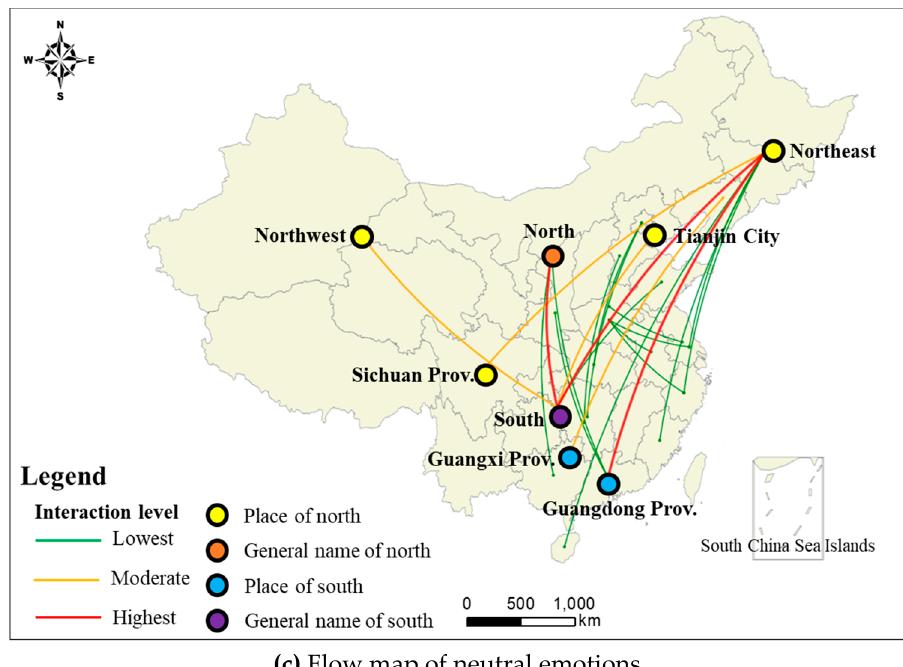
Figure 6. Emotion flow map of people from the south and north of China.